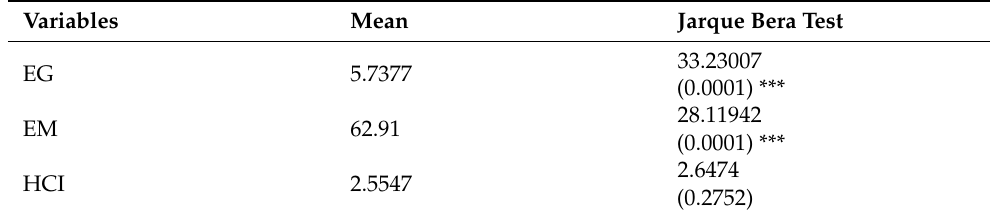
Table 2. Results for descriptive